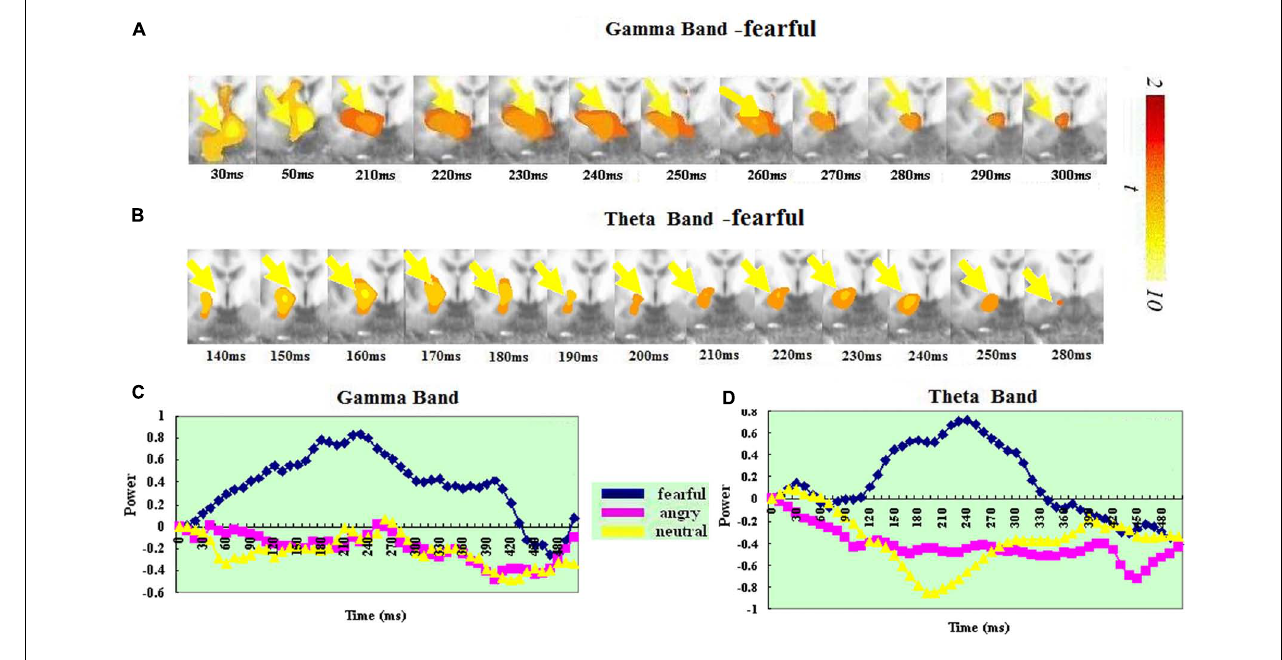
FIGURE 1 | Spatiotemporal profiles for the amygdala in the gamma and theta bands. The brain map series (A,B) indicate the ERS development in specific brain areas with the left hemisphere is on the right and the right hemisphere is on the left. The curves (C,D) represent temporal profiles obtained from a peak voxel in a specified area in the three conditions respectively. The time courses are obtained from the